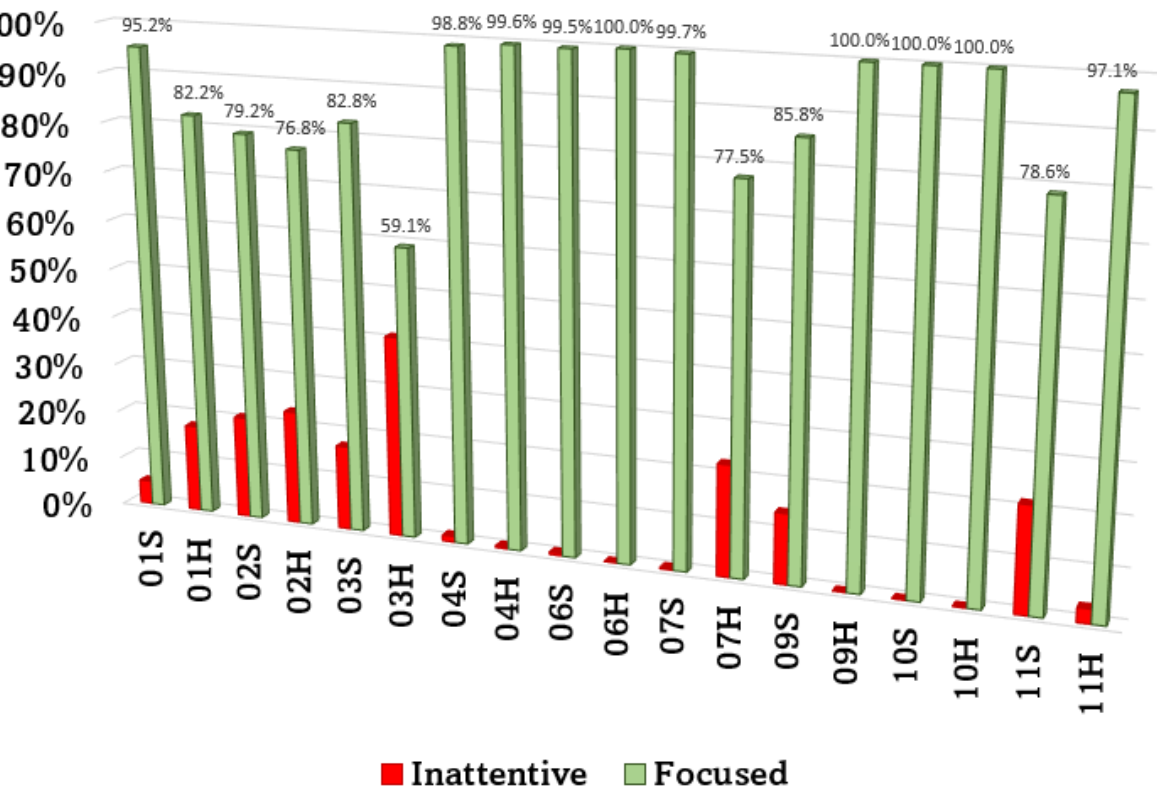
Figure 5. Drivers’ attention analysis. Percentages are computed on the overall number of frames per driving experience.